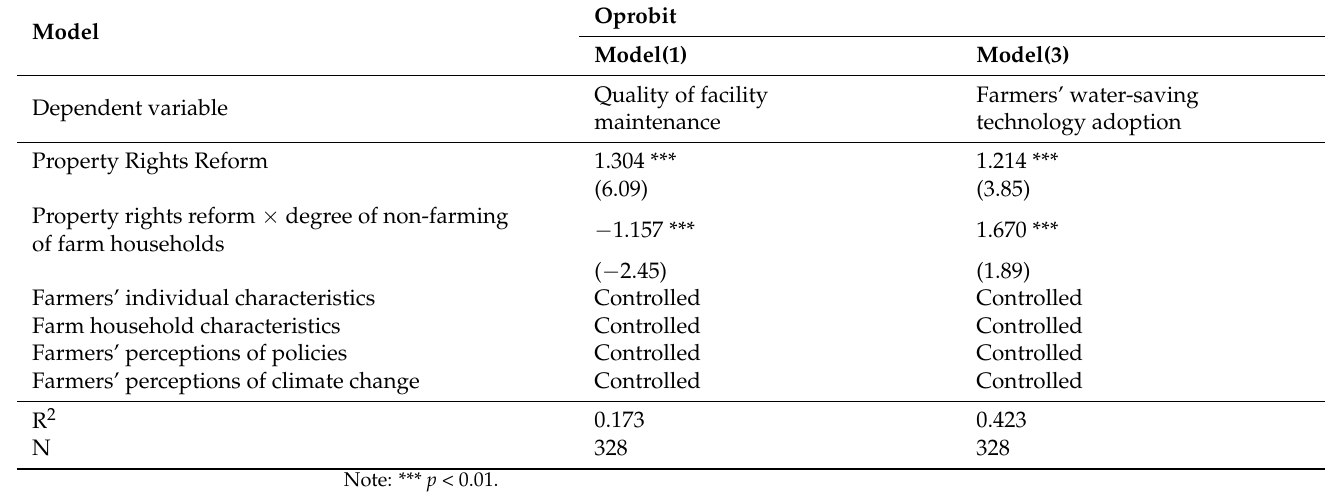
Table 7. Heterogeneity regression results of the degree of non-farming of farm households.